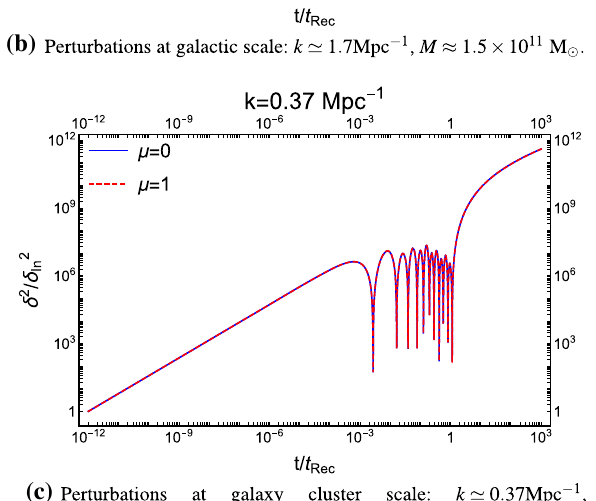
Fig. 2 Density perturbations evolution in time, relative to their initial value. While some anisotropy is present in a because of the magnetic Jeans length (see Sect. 8 and [6]), most of the anisotropic effects of [6] here are suppressed because of thermal pressure in the radiation domi- nated era of the magnetic Jeans length [6] (Eqs. (99b) and